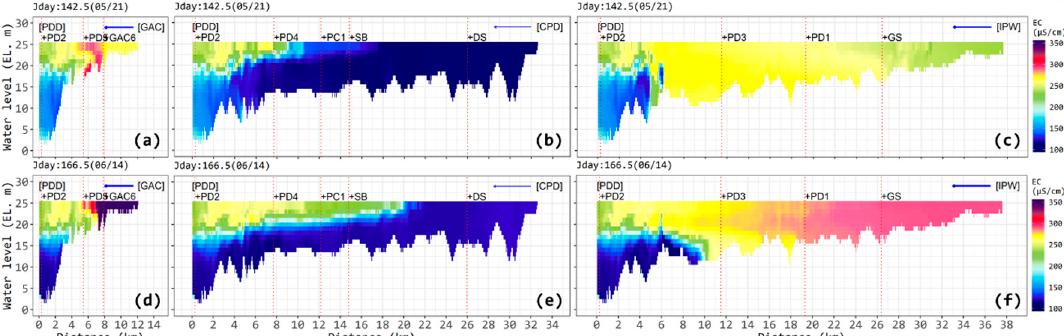
Figure 9. Longitudinal variations of electrical conductivity on Julian day 142.5 ( a – c ) and 166.5 ( d – f ). Left snapshots from GAC to PDD; center snapshots from CPD to PDD; right snapshots from IPW to PDD. Jday and parentheses are the Julian day of year 2016 and month/day (format: mm/dd).